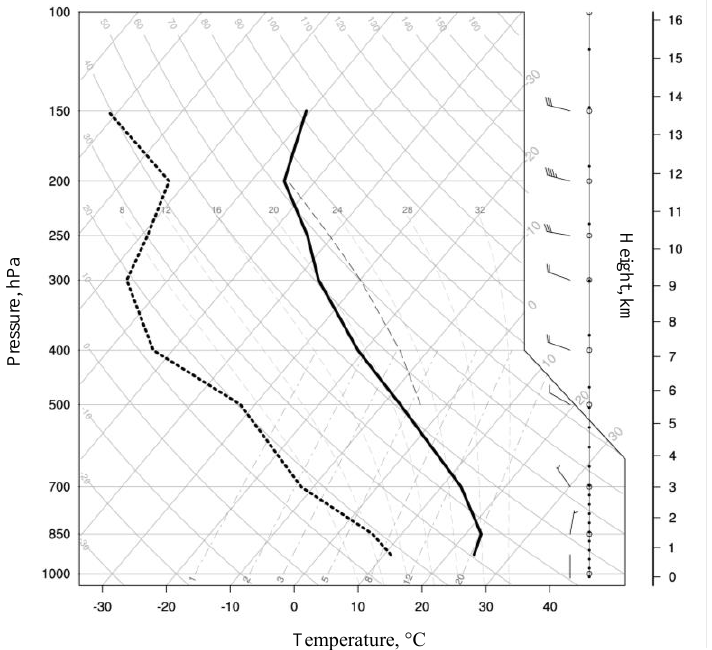
Fig. 4. Radiosounding observed at the AERO meteorological station (32  50' S, 68  48' W) for 8 January 2012 at 9:00 LT. For 8 January 2012, at a regional scale, Fig. 5 indicates that the mean wind speed around 32  S − 68  W is around between 40 and 60 km h − 1 at 850 and 600 hPa, respectively. At both pressure levels, the average wind direction comes from the north-northwest. Additionally, Fig. 6 shows that the average daily thermal gradients around the same point have an absolute thermal stability at 850 and 600